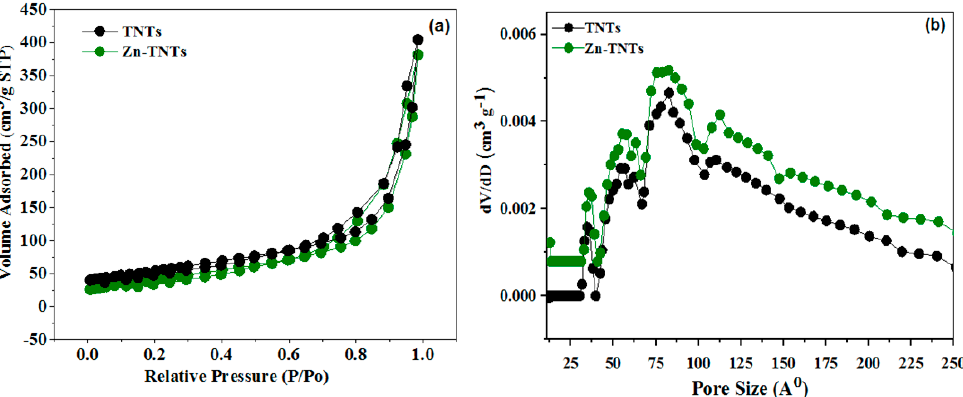
Figure 4. ( a ) N 2 isotherms ( b ) pore size distribution of undoped TNTs and Zn-doped TNTs (Zn- TNTs).